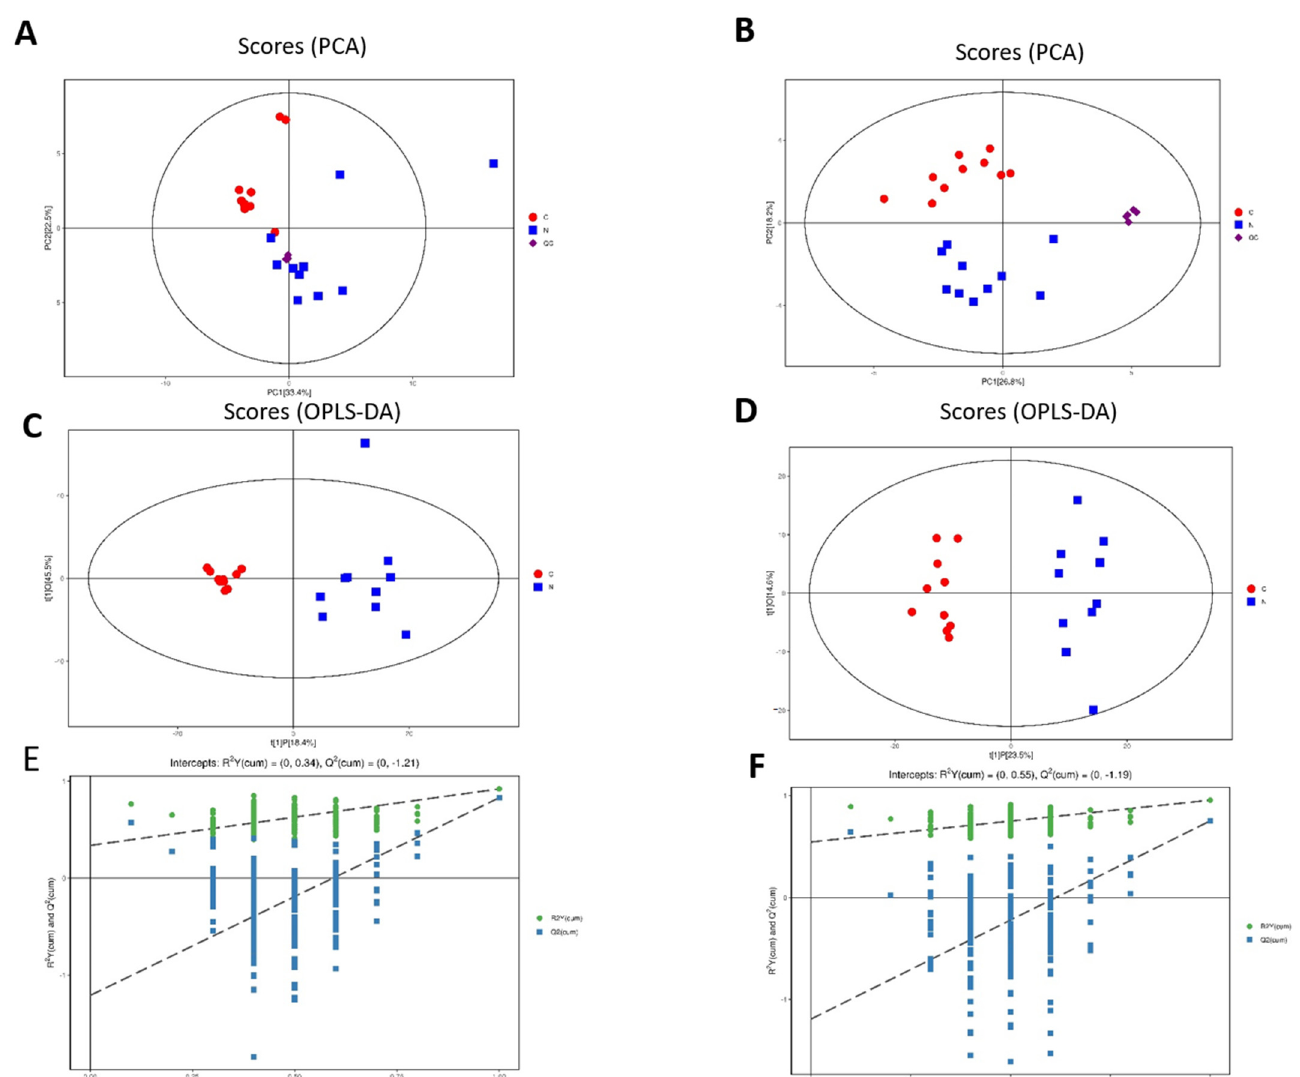
Figure 1. Qualification of untargeted metabolomics analysis. ( A , B ) The PCA analysis of the included samples in both positive and negative models. ( C , D ) OPLS-DA score plots under the positive and negative models. ( E , F ) Permutation analysis plots of the OPLS-DA model under the positive and negative